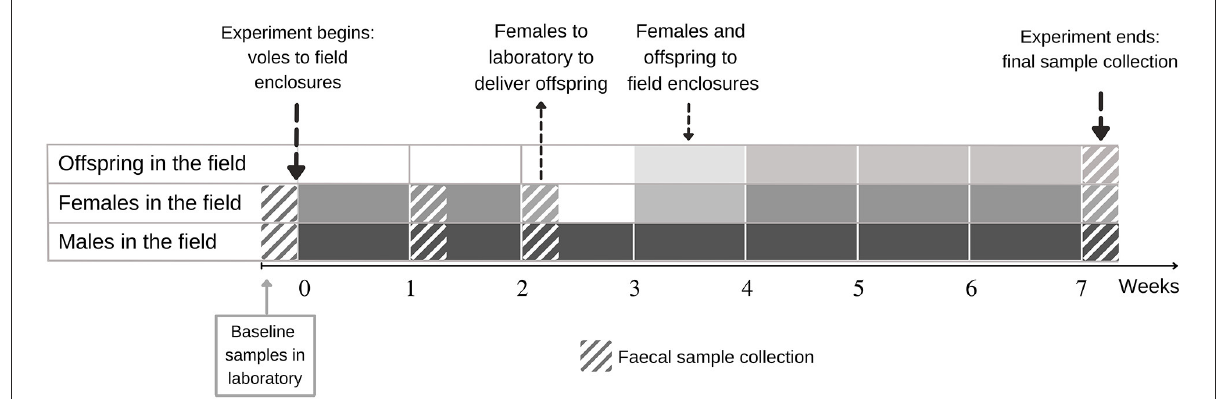
FIGURE1 Design of experimental study on the effect of lab-to-field transition on the gut microbiota of the selection lines of bank voles that differ in metabolic capacity. Fecal samples were first collected in the laboratory, after which voles were transferred to the field enclosures for 7 weeks. The animals were captured alive for fecal sample collection and body mass measurement in weeks 1, 2, and 7. Females were taken to the laboratory in week 2 to deliver offspring. Within 3 days of the delivery the family was returned to the field. For the offspring, fecal samples were collected only in week